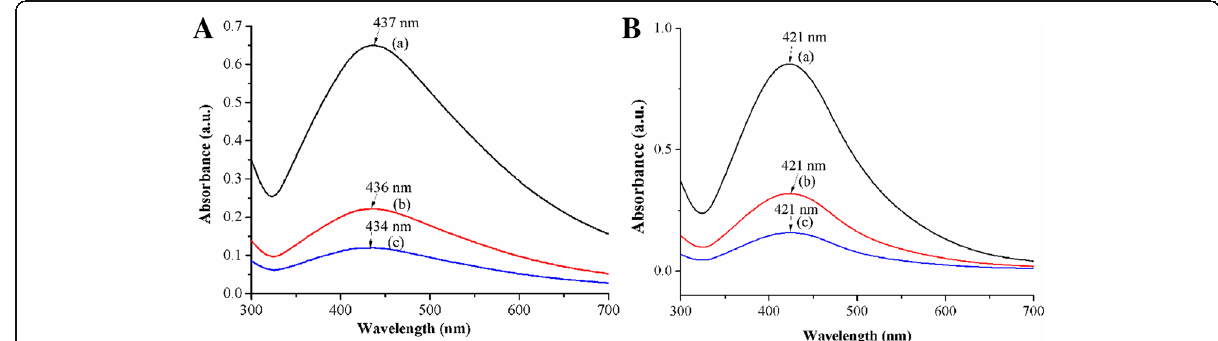
Fig. 5 UV-Vis spectra of a linear copolymers and b star copolymers micelles stabilized AgNPs solution at PDMAEMA/AgNO 3 molar ratio = 6/1 after 1 month at the diluted times of 1 (a), 3 (b), and 6 (c),